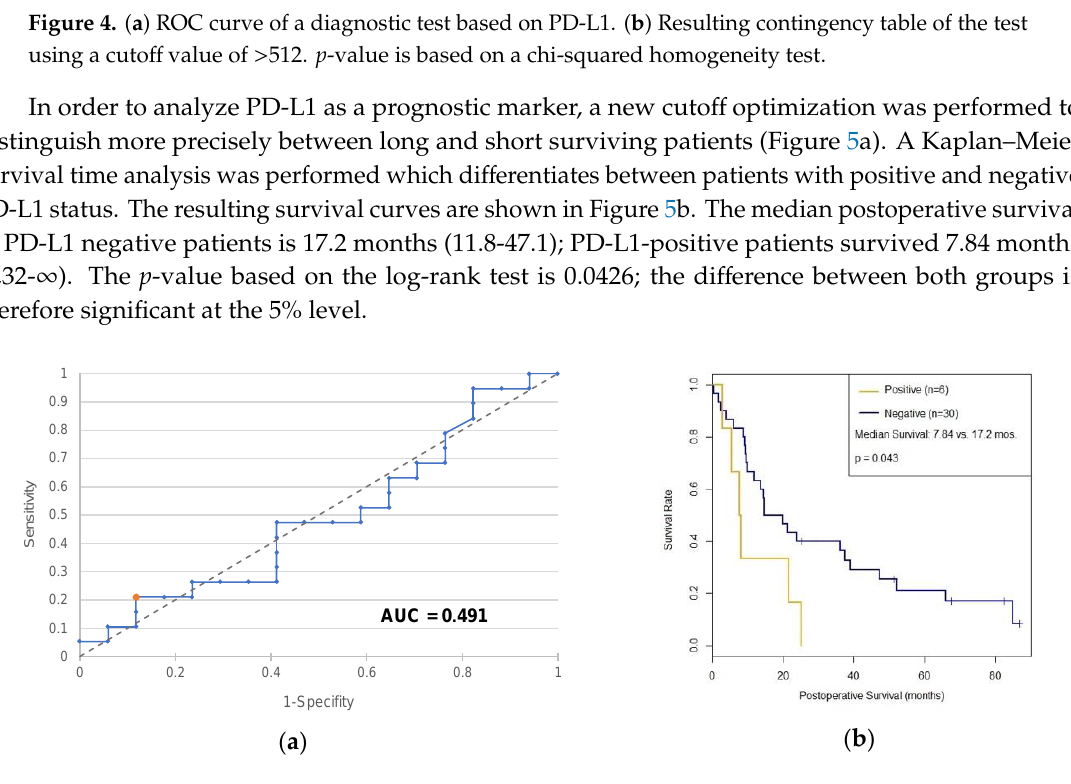
Figure 5. ( a ) ROC curve of a prognostic test based on PD-L1. ( b ) Survival analysis according to Kaplan–Meier as a function of PD-L1 status using >299 as cutoff. Non-informative censors are marked as a dash.